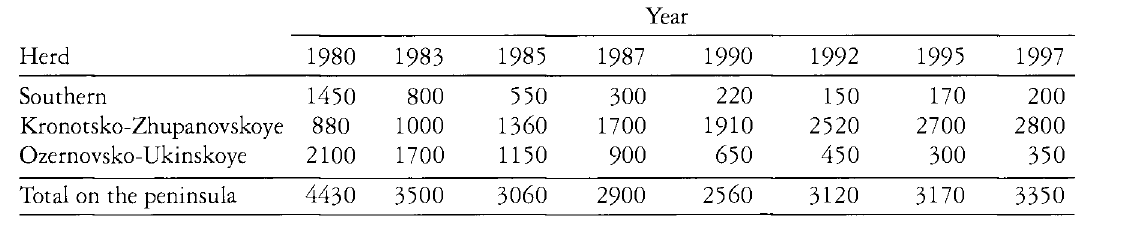
Table 1. Population dynamics of wild reindeer in Kamchatka,